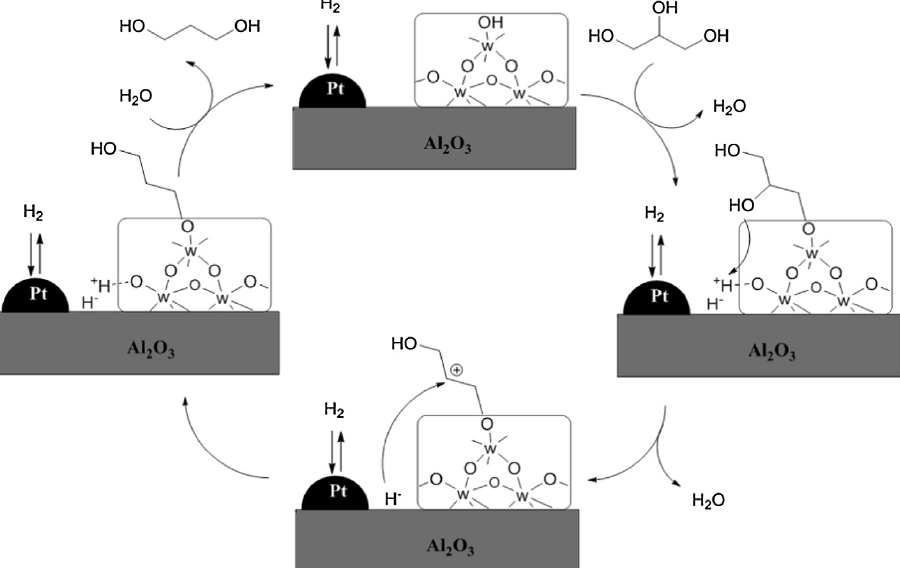
Figure 17. The reaction mechanism on the Pt/WO x /Al 2 O 3 catalysts. Reproduced from [65] with permission from Elsevier.